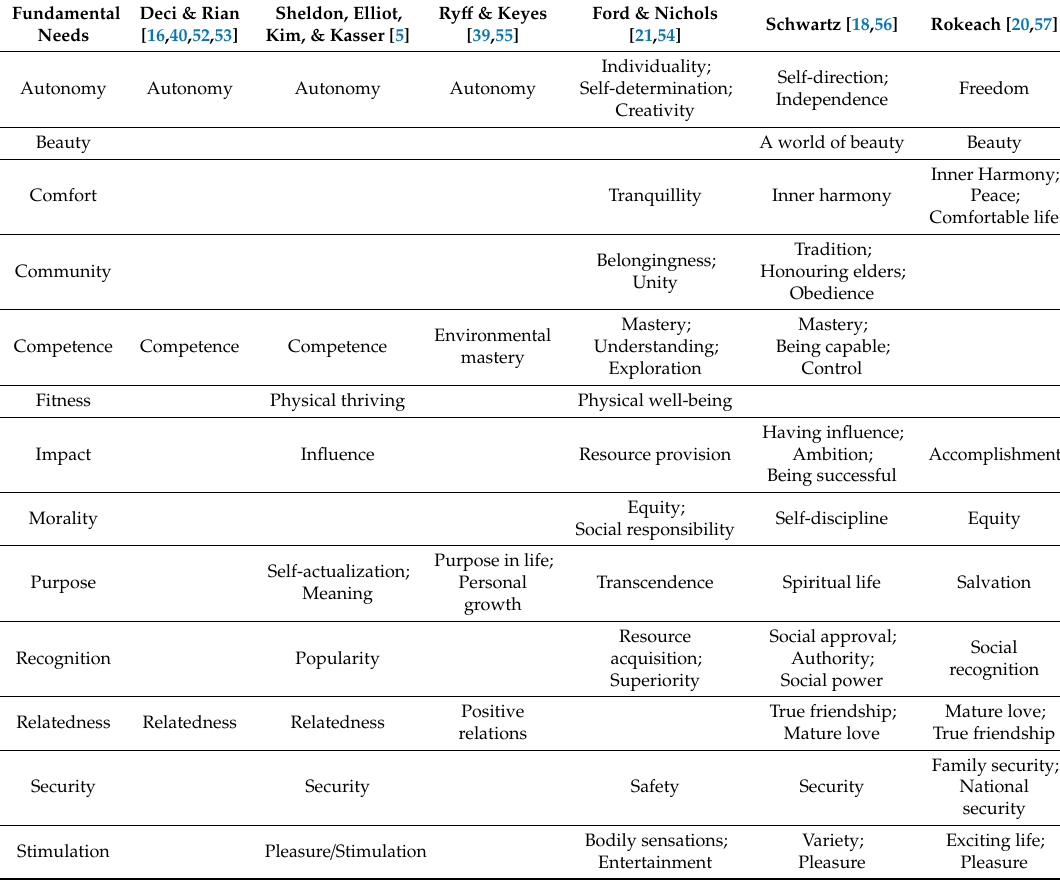
Table A1. Five sources of fundamental psychological